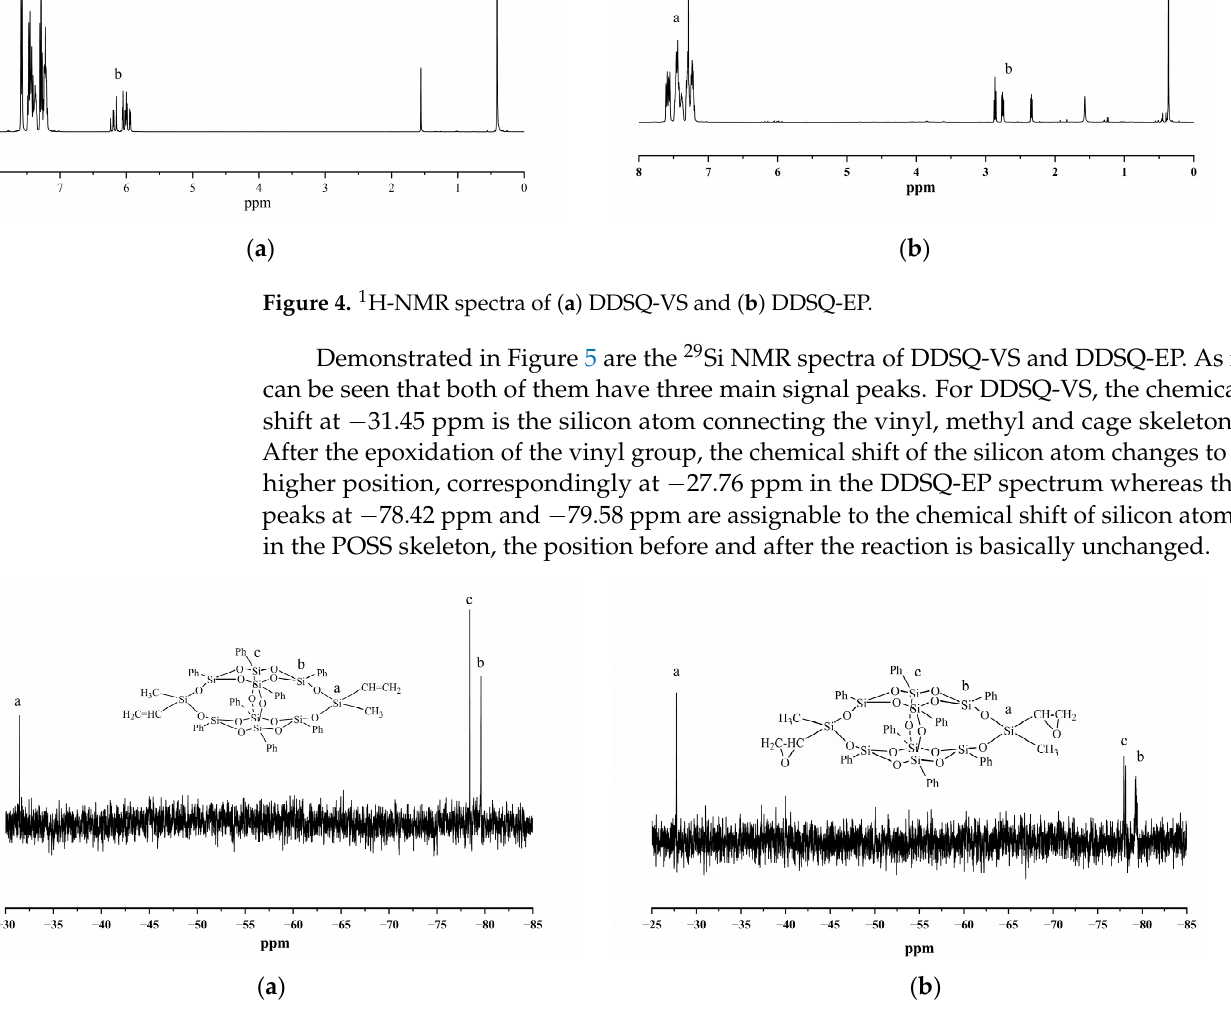
Figure 5. 29 Si-NMR spectra of ( a ) DDSQ-VS and ( b ) DDSQ-EP. MALDI-TOF mass spectroscopy and their mass spectra are presented in Figure 6. For DDSQ-VS, the molecular weight was measured to be M = 1227.2 corresponding to the strong signal peak at 1227 m/z , which was exactly identical with theoretical value. For DDSQ-EP, the position of the single peak appears at 1259.8 m/z , indicating that the relative molecular mass is 1259.8 which is consistent with the theoretical value (1237.8 + 23). The target product was successfully confirmed by infrared spectrum, nuclear magnetic reso- nance spectrum, nuclear magnetic silicon spectrum and MALDI-TOF spectrum, and the purity was high.